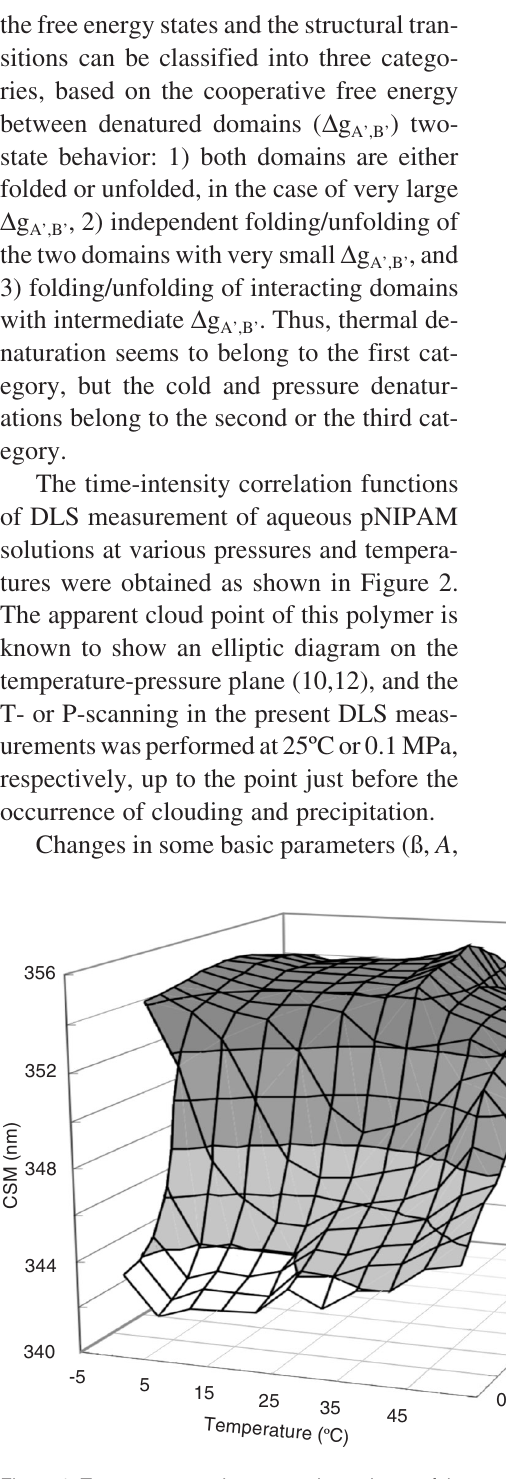
Figure 1. Temperature and pressure dependence of the center of spectrum mass (CSM) of yeast phosphoglycerate kinase fluorescence. λ ex = 295 nm, [E] = 3.5 µM in 100 mM Tris- HCl, pH =